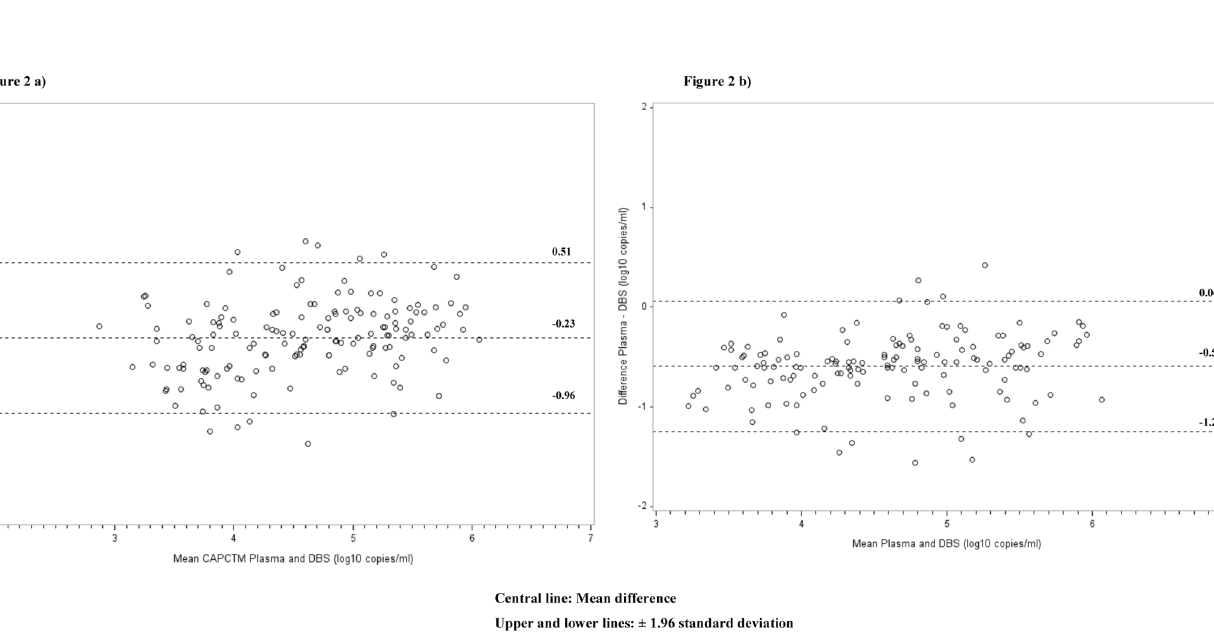
PLOS ONE | https://doi.org/10.1371/journal.pone.0179316 June 16,